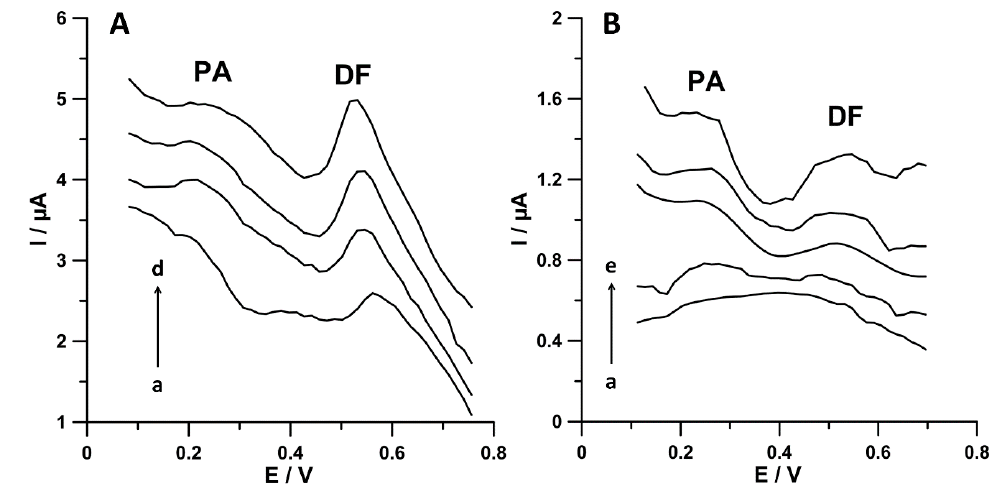
Figure 10. DPAdSV curves registered at the SPCE/MWCNTs-COOH during PA and DF simultaneous analysis in ( A ) wastewater samples purified in a sewage treatment plant (a) 5 mL of sample, (b) as (a) + 5.0 nmol L − 1 PA and 0.5 nmol L − 1 DF, (c) as (a) + 10.0 nmol L − 1 PA and 1.0 nmol L − 1 DF, and (d) as (a) + 15.0 nmol L − 1 PA and 1.5 nmol L − 1 DF; ( B ) Bystrzyca river water sample: (a) 5.0 mL of sample, (b) as (a) + 5.0 nmol L − 1 PA and 0.5 nmol L − 1 DF, (c) as (a) + 10.0 nmol L − 1 PA and 1.0 nmol L − 1 DF, (d) as